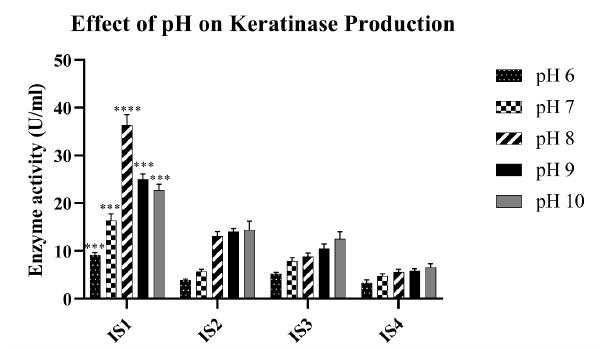
Figure 5. Effect of pH on the Keratinase activity of the isolates. Graphical representation showing the amount of keratinase activity by the microorganisms at different pHs. Y-axis indicates the enzymatic activity expressed in U/ml and X-axis denotes the test isolates. Data (n = 3) illustrated in the bar diagram as mean +SD. ****p < 0.0001 as determined by Two-way ANOVA (IS1 to IS4 represents the isolates). Though the enzymatic activities of IS1 at different pHs showed similar statistical significance, the activity at pH 8 was the most significant. Also, the enzymatic activity at pH 8 was the highest. Hence, pH 8 was considered as the optimum pH for